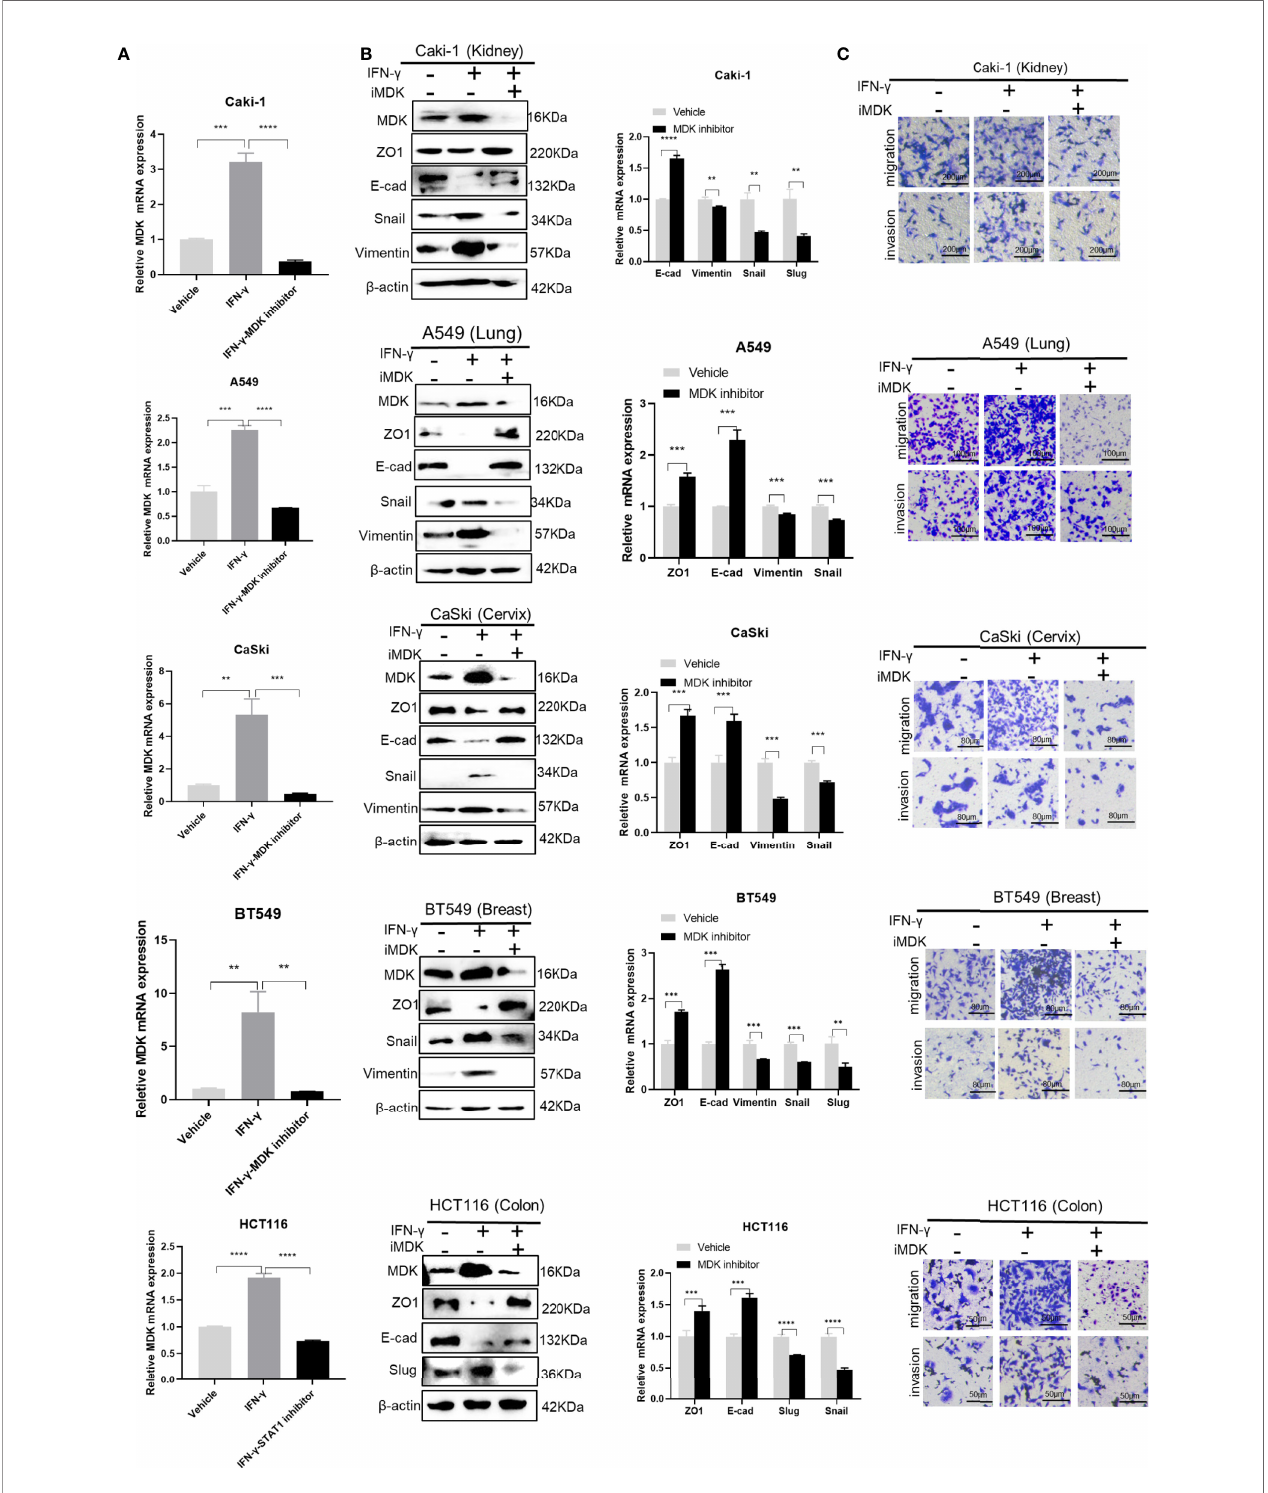
FIGURE 6 | Targeting MDK abrogates IFN- g -induced tumor metastasis. (A) RT-qPCR validation of MDK suppression by MDK inhibitor in IFN- g -treated cancer cells. (B) Western blotting and RT-qPCR assays to assess the effect of iMDK on IFN- g -activated EMT in fi ve cancer cell lines. (C) Transwell assays to examine the effect of iMDK on IFN- g -driven cell invasion and migration. Data are shown as the mean ± standard deviation (SD). **P < 0.01, ***P < 0.001, ****P <